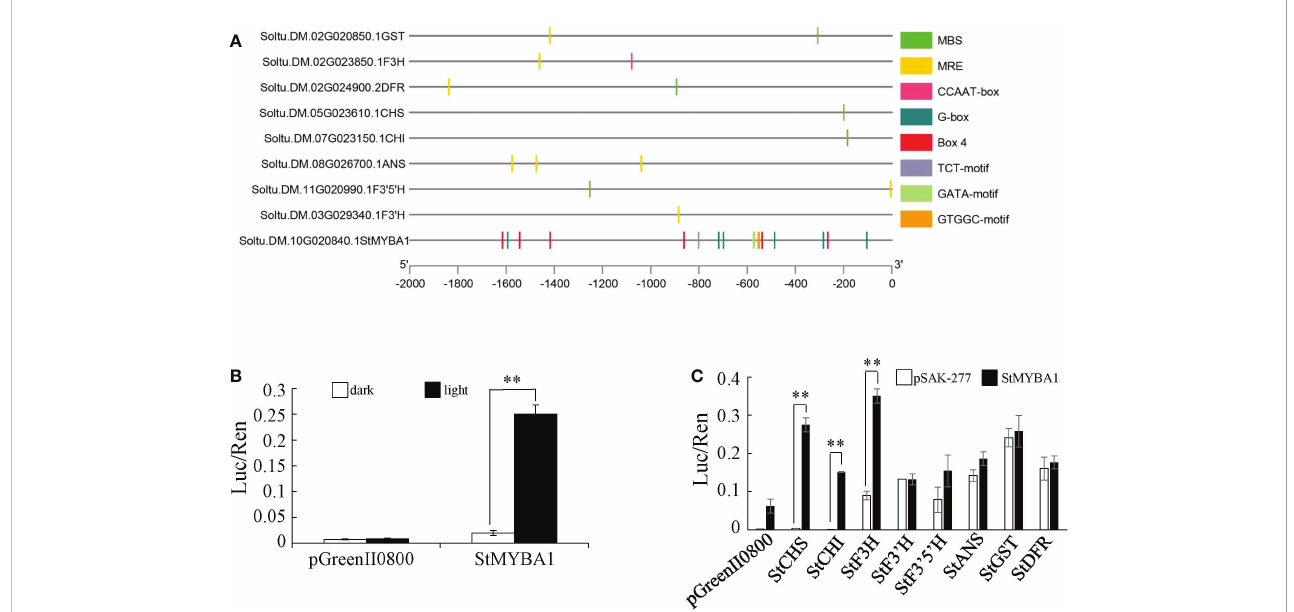
FIGURE 5 Light Response analysis of StMYBA1 Gene and its regulation on structural genes. (A) Distribution of main core elements of StMYBA1 and structural gene promoters. (B) Activity analysis of StMYBA1 promoter under light and dark conditions. (C) Regulation of StMYBA1 on structural genes related to anthocyanin biosynthesis. Signi fi cant differences (LSD) between means of the dark and light treatments, and pSAK-277 and StMYBA1 are indicated by asterisks (** p <